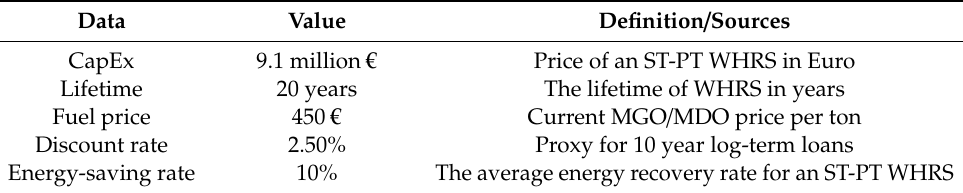
Table 4. Input Parameter for the Ferries Capital Budgeting.